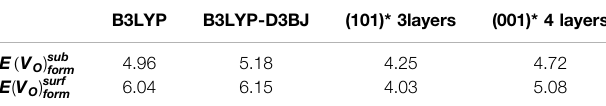
TABLE 5 | Oxygen vacancy formation energies in both subsurface, E(V O ) sub form , and surface, E(V O ) surf form , calculated at B3LYP and B3LYP-D3BJ level of the theory according to Eq. 8 . Values are given in eV. Oxygen vacancy formation energies from Ref.